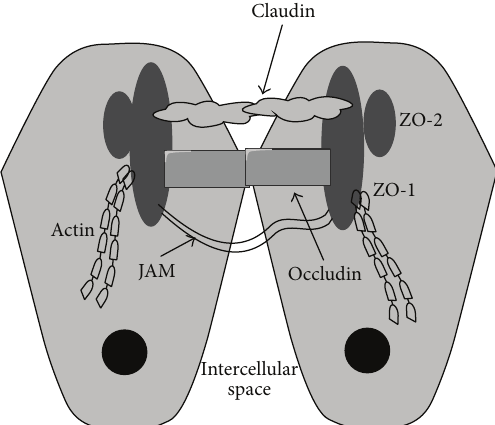
Figure 1: Tight junction structures. The tight junction is organized by multiple transmembrane proteins, including junctional adhesion molecules (JAM), occludin, claudins, and zona occludens (ZO), which interact in a coordinated manner to form intestinal